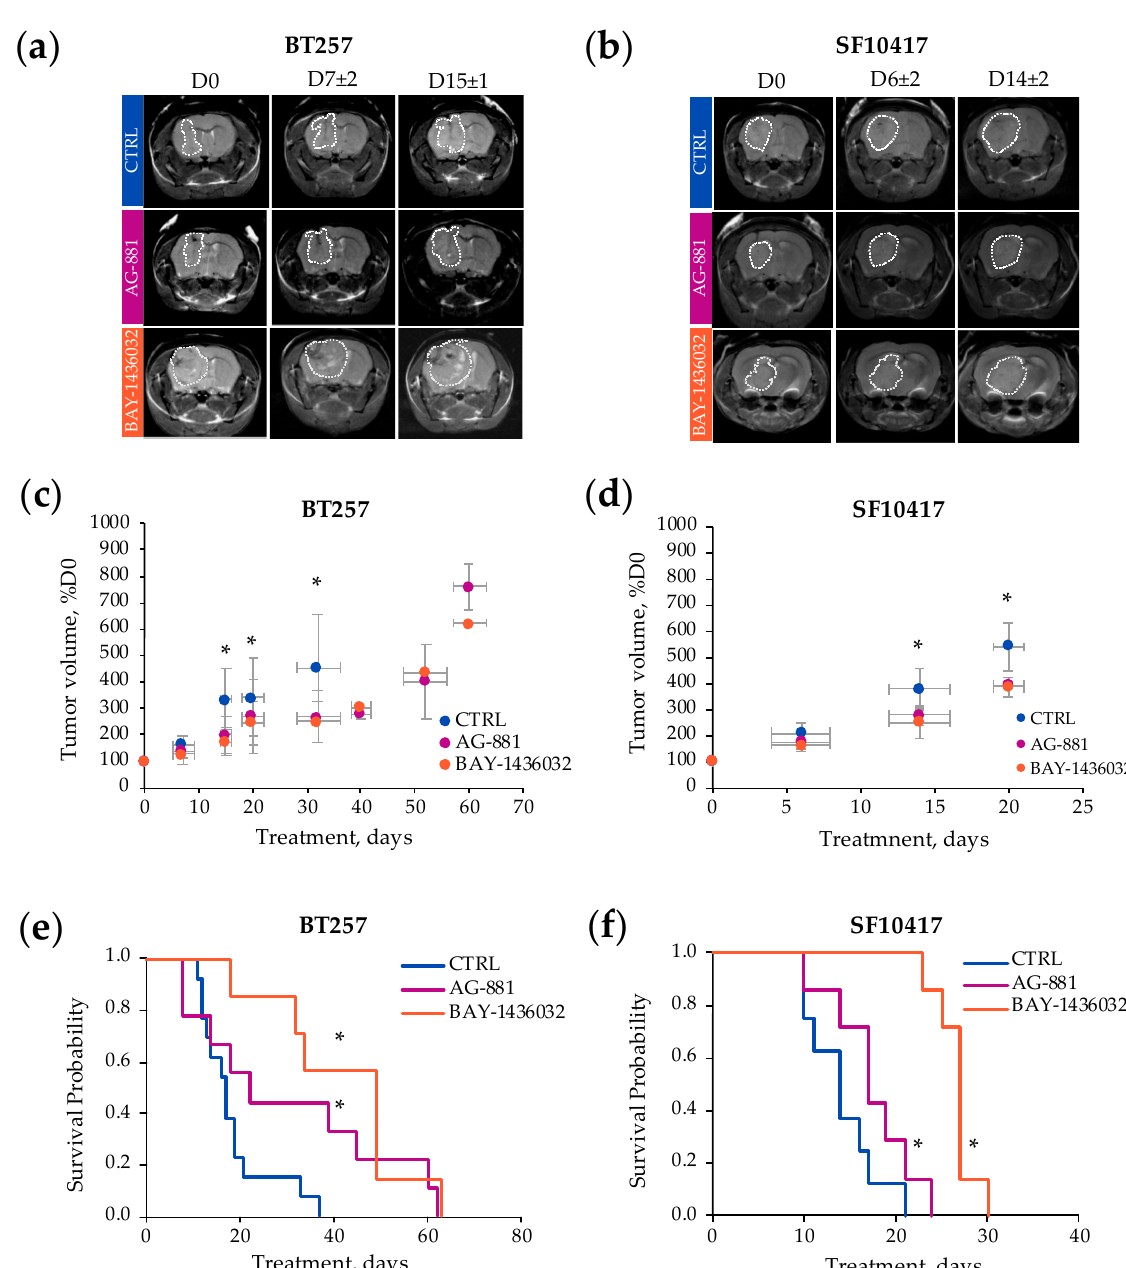
Figure 3. Representative axial T2-weighted images of control (top line, blue), AG-881 (middle line purple) and BAY-1436032 (bottom line orange)-treated BT257 tumor-bearing mice at D0, D7 ± 2 and D15 ± 1 ( a ) and SF10417 tumor-bearing mice at D0, D6 ± 2 and D14 ± 2 ( b ). Temporal evolution of average tumor volume (percentage of D0) for the BT257 ( c ) and the SF10417 ( d ) models (control in blue, AG-881 in purple, BAY-146032 in orange). Kaplan-Meier survival plot of BT257 ( e ) and SF10417 ( f ) tumor-bearing mice treated with either AG-881 or BAY-1436032 when compared to controls. * p -value ≤ 0.05.